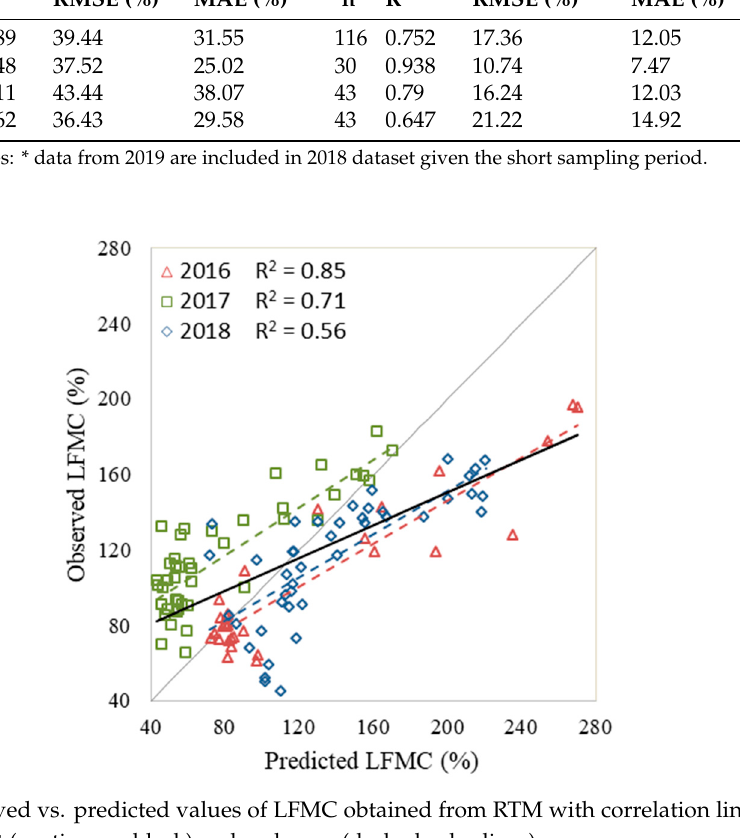
Table 6. Comparison between observed data and LFMC estimations from RTM simulations and NLR empirical model for MCD43A4 images. RMSE, root mean square error; MAE, mean absolute error; n, sample size.